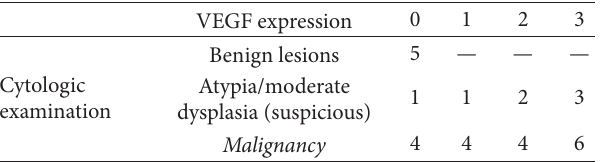
Table 3: The correlation between the results of exfoliative cytology and the immunocytochemical analysis of VEGF expression in 30 patientswithprecancerousorsuspectedmalignantlaryngeallesions. VEGF expression 0 1 2